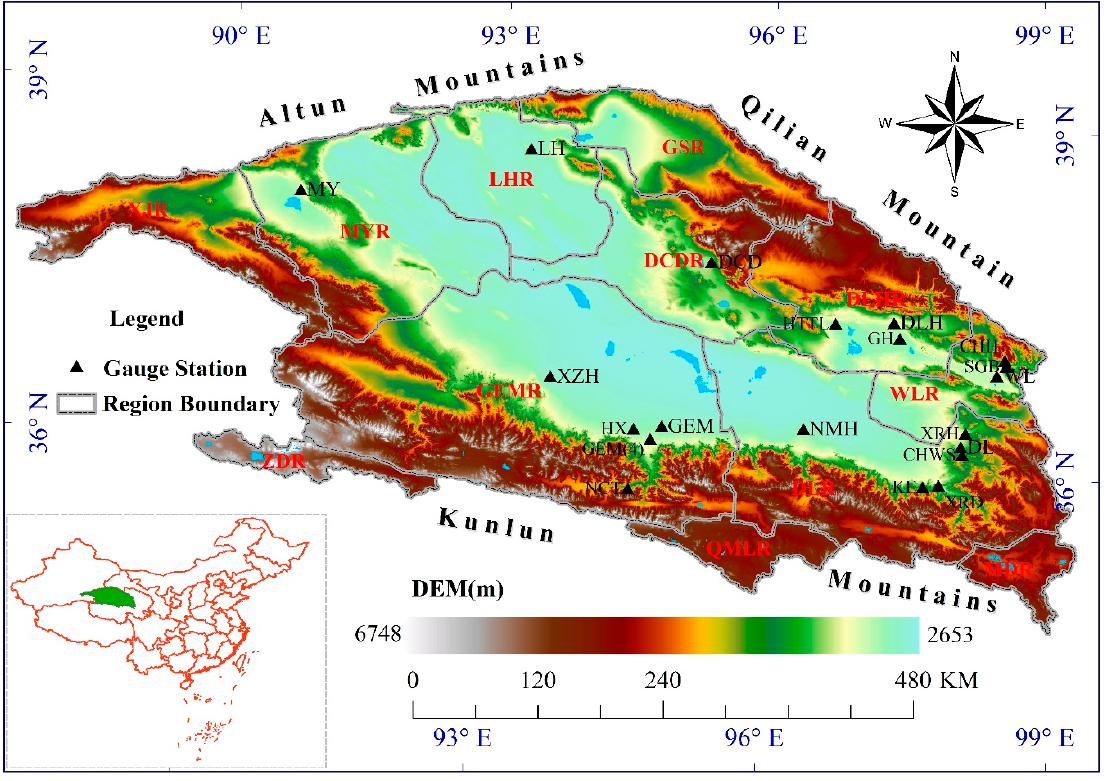
Figure 1. The research area of the Qaidam Basin.